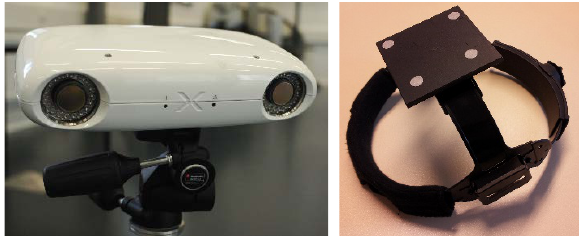
Figure 7. Left: AXIOS stereo camera CamBar B2, Right: light head belt with a targeted